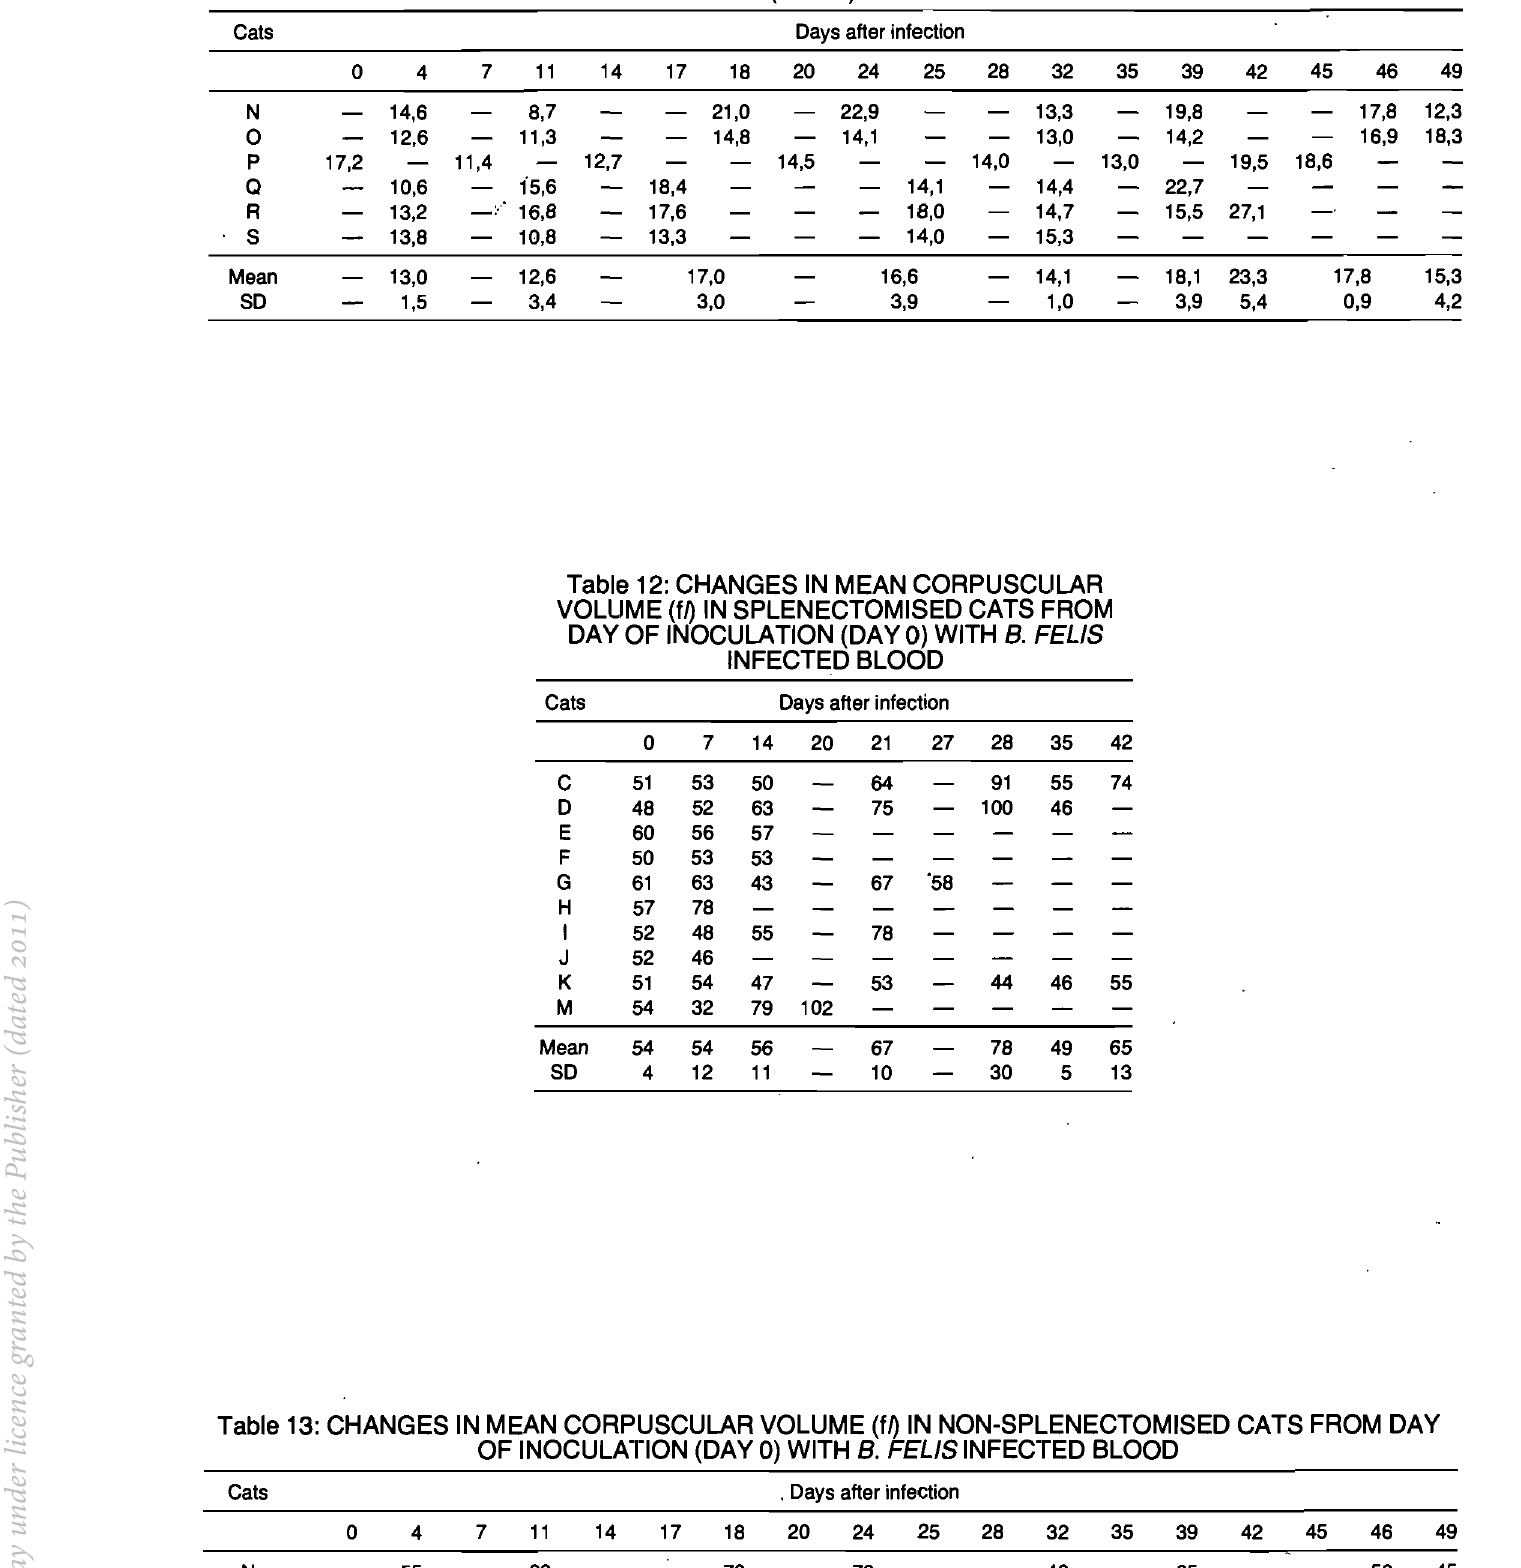
Table 11: CHANGES IN MEAN CORPUSCULAR HAEMOGLOBIN (pg) IN NON-SPLENECTOMISED CATS FROM DAY OF INOCULATION (DAY 0) WITH B. FELIS INFECTED BLOOD